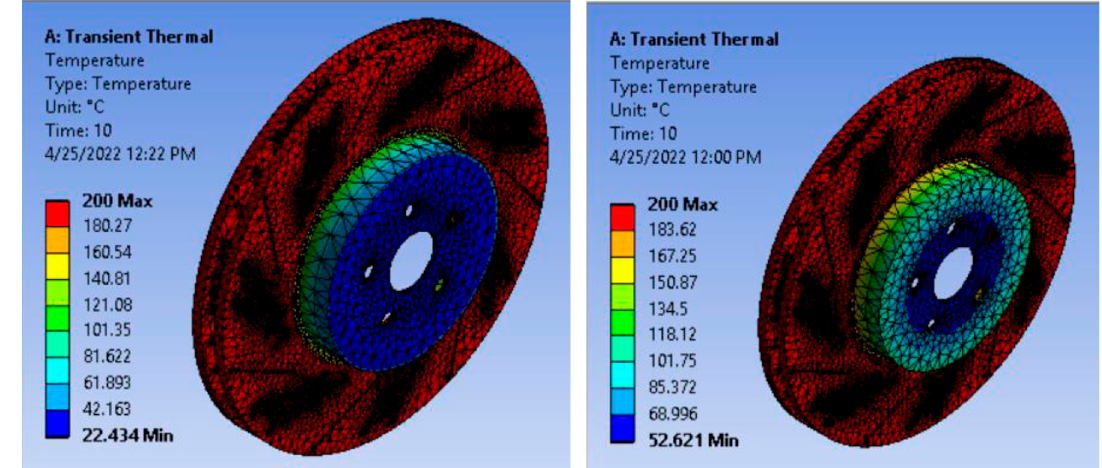
Figure 10. Temperature distribution in aluminum alloy and AMNCs ventilated disc.